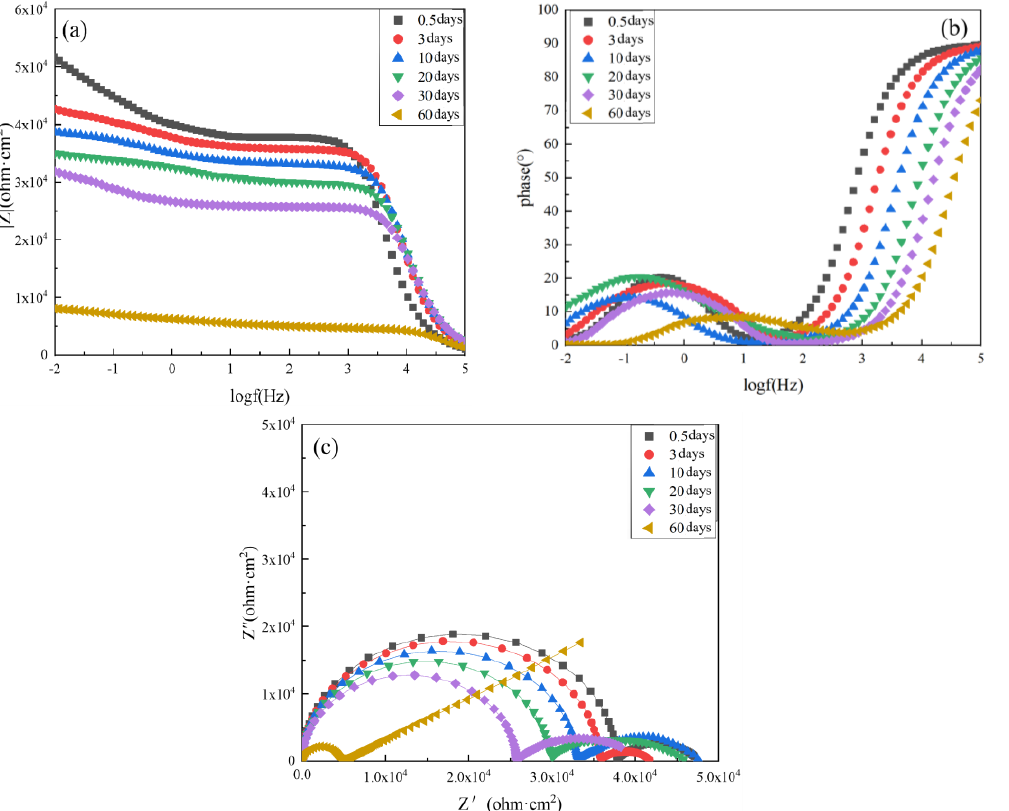
Figure 10. EIS results of composite coating prepared with 6 wt.% spherical aluminum powder after UV aging for 100 days and immersion for various lengths of time in 3.5 wt.% NaCl solution: ( a ) Bode diagram, ( b ) phase angle diagram, and ( c ) Nyquist diagram.